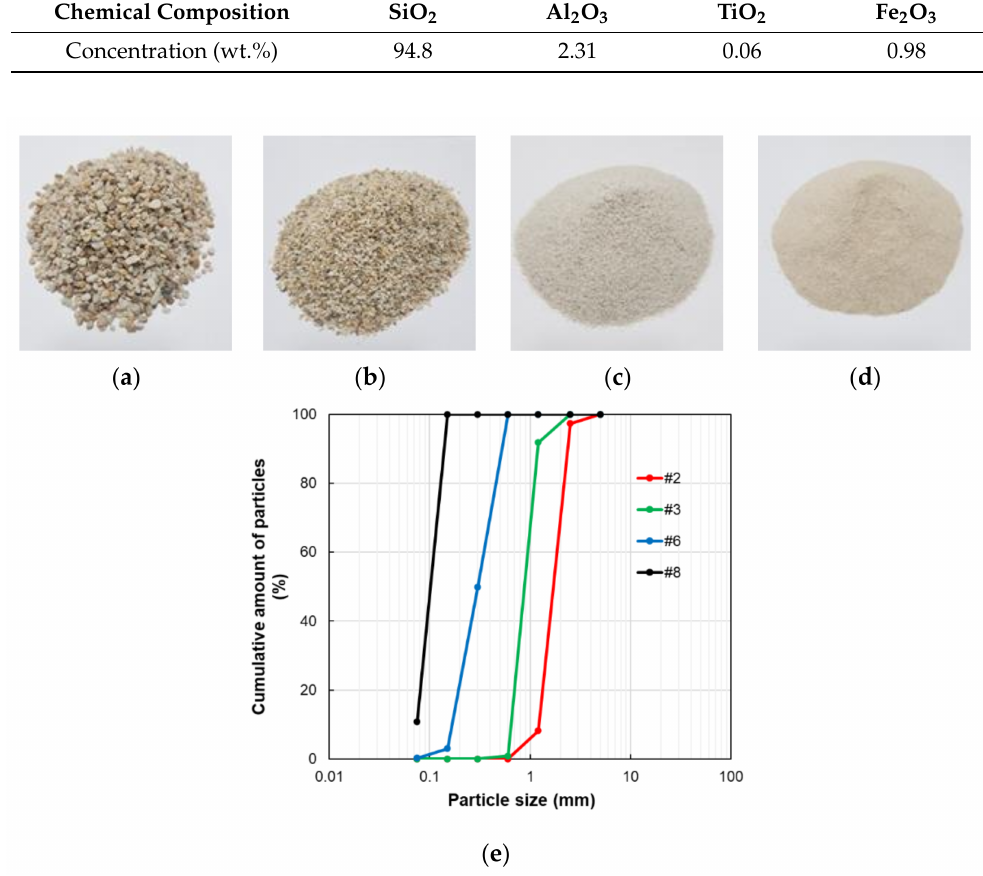
Figure 1. The appearances ( a – d ) and distribution curve ( e ) of the aggregates applied to the specimen. The mix ratio of each specimen was based on the amount of aggregate #2